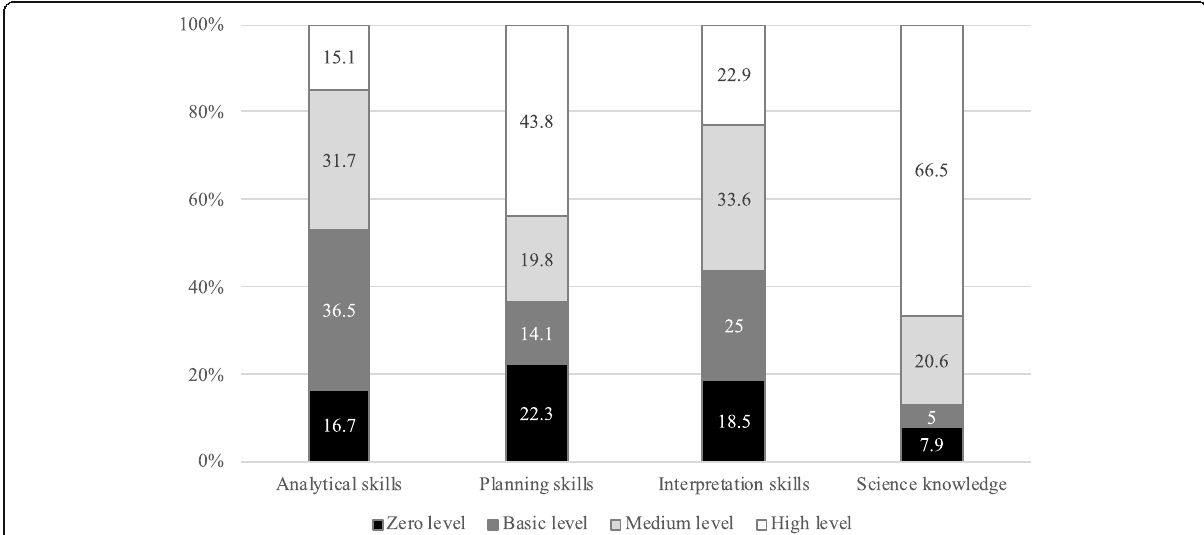
Fig. 2 The ratio of students on different levels of dimensions of the SIT-PE test. In addition, students ’ perception was used to evaluate the appropriateness of the test for the target group: 10.9% of students found that it was very difficult, 28.6% found it rather difficult, 51.6% moderately difficult, 7.1% rather easy, and 1.7% easy. While 59.2% of the students considered their computer skills definitely good enough for completing the test, 36.2% regarded them as more or less sufficient, and only 4.4% as